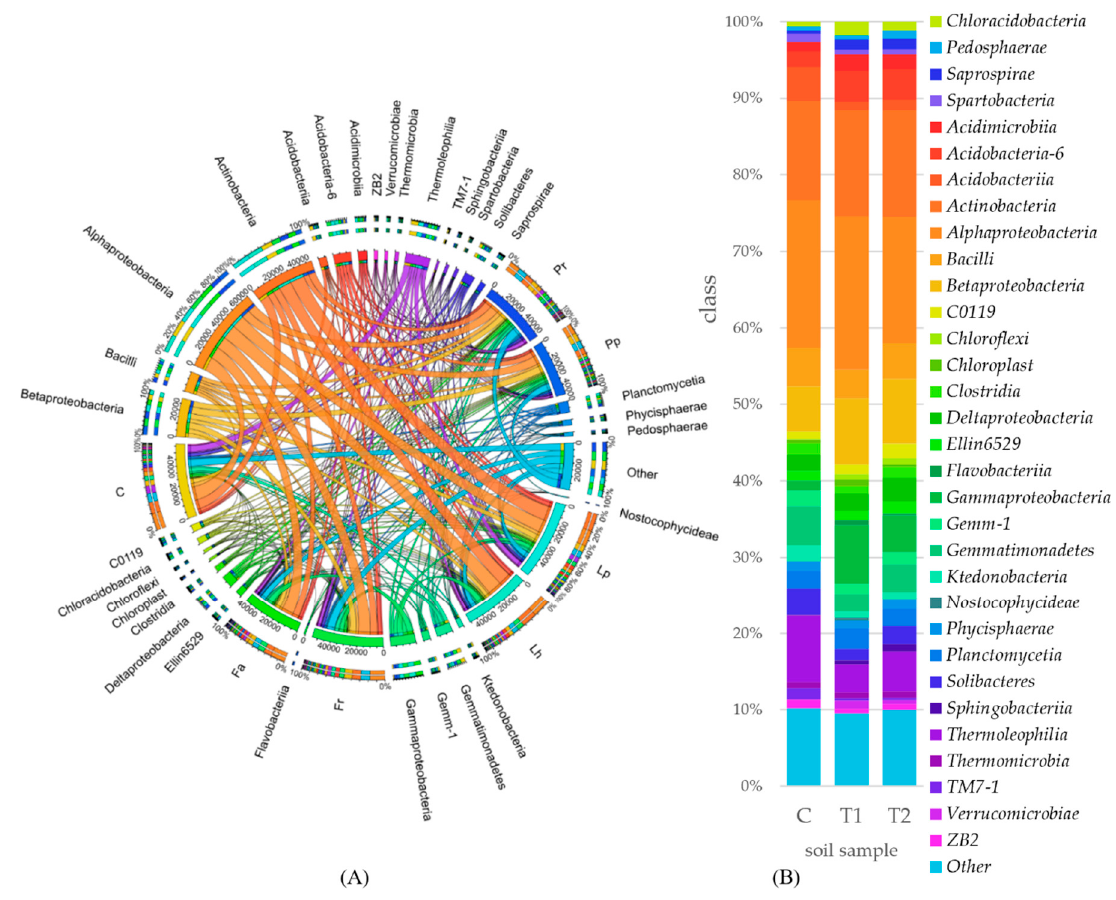
Figure 6. Bacterial communities at the class level ( A ) depending on the species of grass, ( B ) depending on grass type (fodder or lawn). Abundances <1% are gathered into the category “other”. C—unsown soil; T1—average bacteria abundance in soils sown with fodder grasses; T2—average bacteria abundance in soils sown with lawn grasses. Lh— Lolium x hybridum Hausskn; Fa— Festuca arundinacea ;